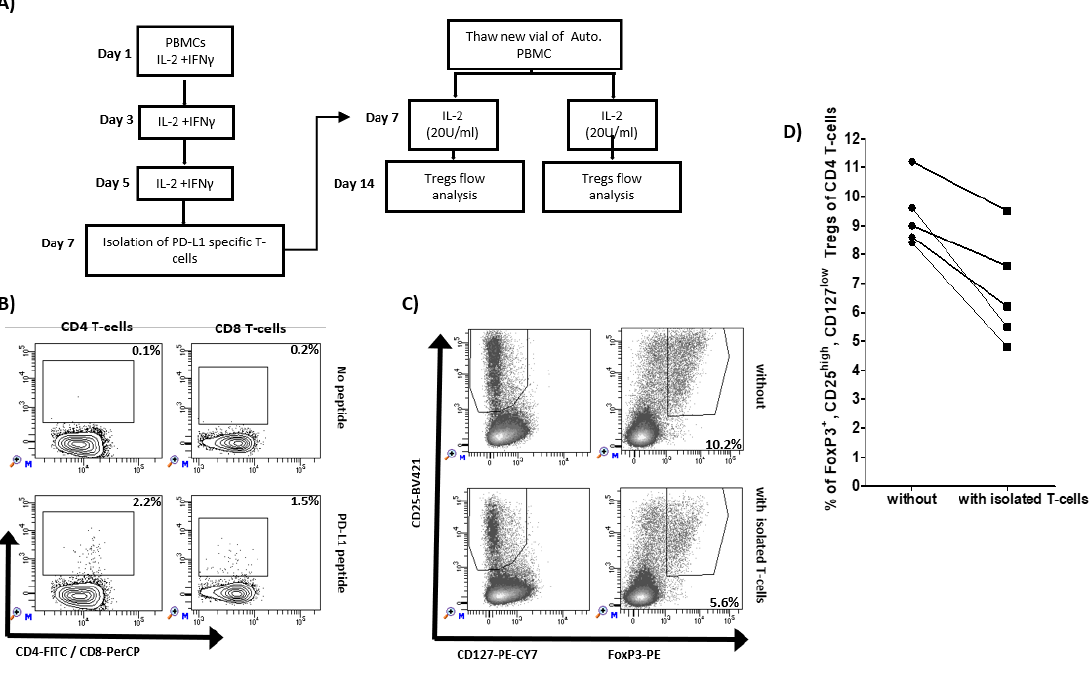
FIGURE 2: Impact of IFN- γ -induced PD-L1-specific T cells on regulatory T cells. (A) Experimental set up: PBMCs from five healthy donors were stimulated three times with IL-2 and IFN- γ . On day 7, PD-L1 specific T cells were isolated using IFN- γ secretion and capture assay. The isolated cells were added to freshly thawed autologous PBMCs. On day 14, frequency of Tregs in cultures with or without addition of iso- lated T cells were analyzed using flow cytometry analysis. (B) Example of flow analysis of PD-L1 specific CD4 and CD8 T cells isolation on day 7. (C) Example of gating strategy of FoxP3 + , CD25 high , CD127 low Tregs of CD4 T cells. (D) Percentage of FoxP3 + , CD25 high , CD127 low Tregs of CD4 T-cells from five different healthy donors without and with addition of isolated PD-L1 specific T